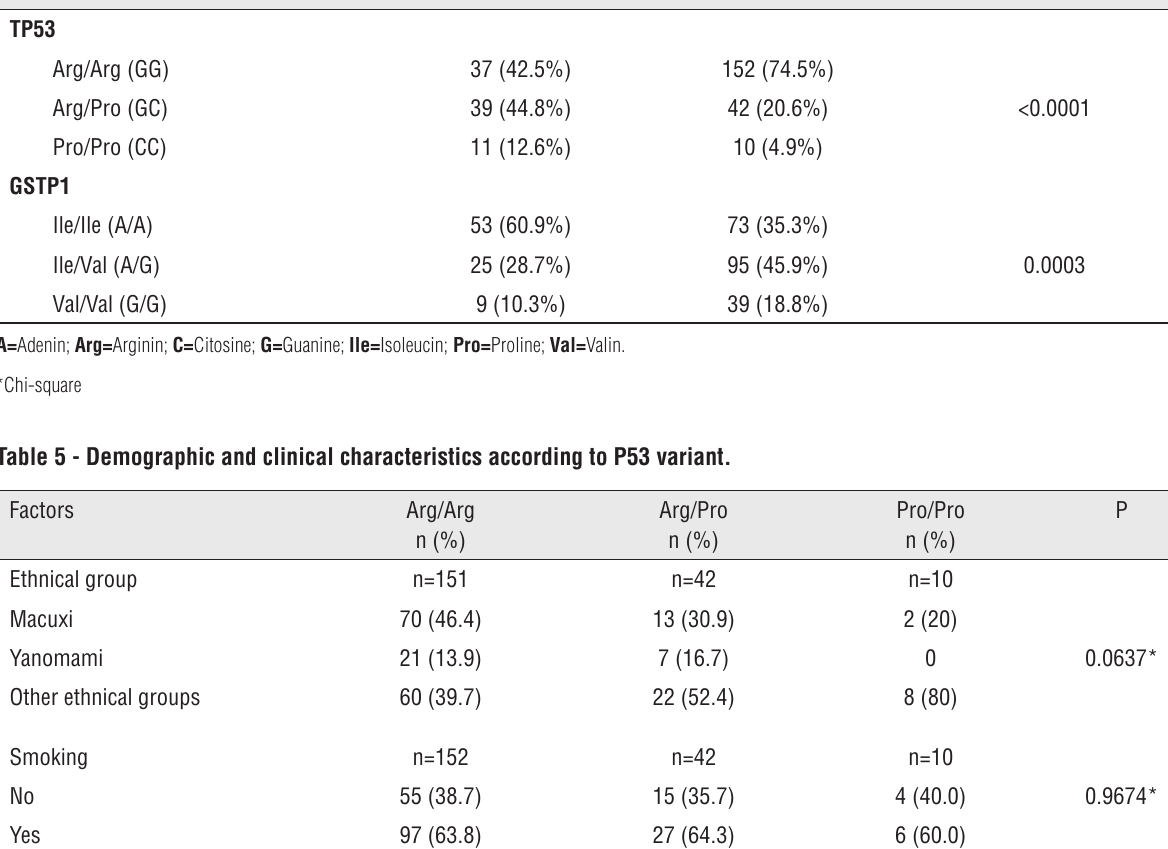
Table 4 - Frequency of variants TP53 and GSTP1 in non-Indians and Indias. Characteristic